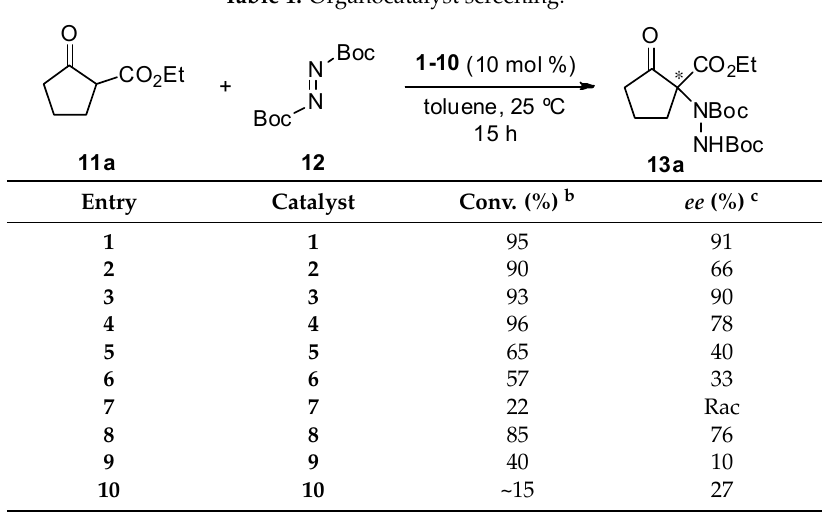
Table 1. Organocatalyst screening. a